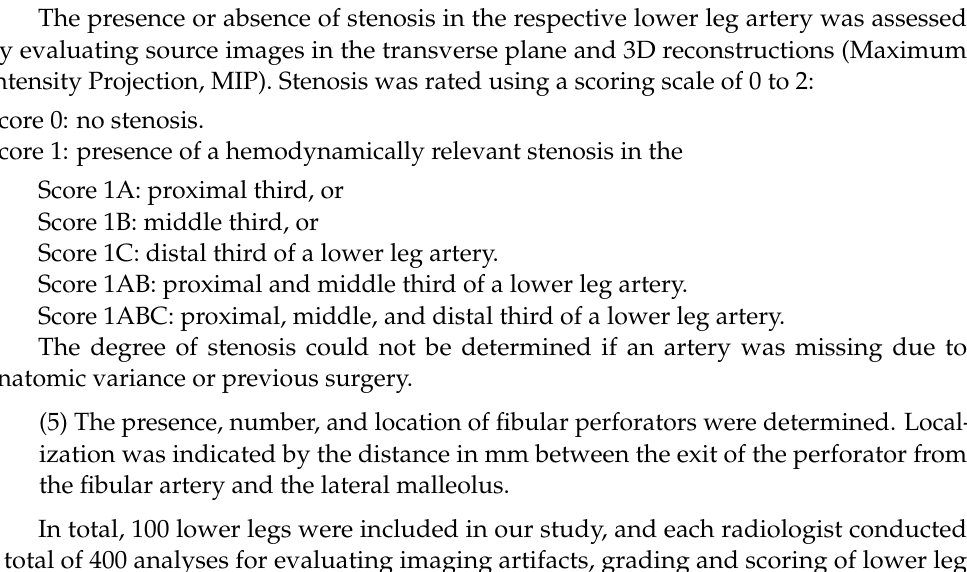
Figure 2. Vessel visualization. Schematic illustration of the visualization of lower leg arteries based on the grading scoring system introduced in the “Image Analysis” section. Grade 1 is shown in panel ( a ), grade 2 in panel ( b ), grade 3 in panel ( c ), and grade 4 in panel ( d ). The white circles indicate lower leg arteries with barely visible lumen (grade 1) and poorly defined vessel boundaries (grade 2).